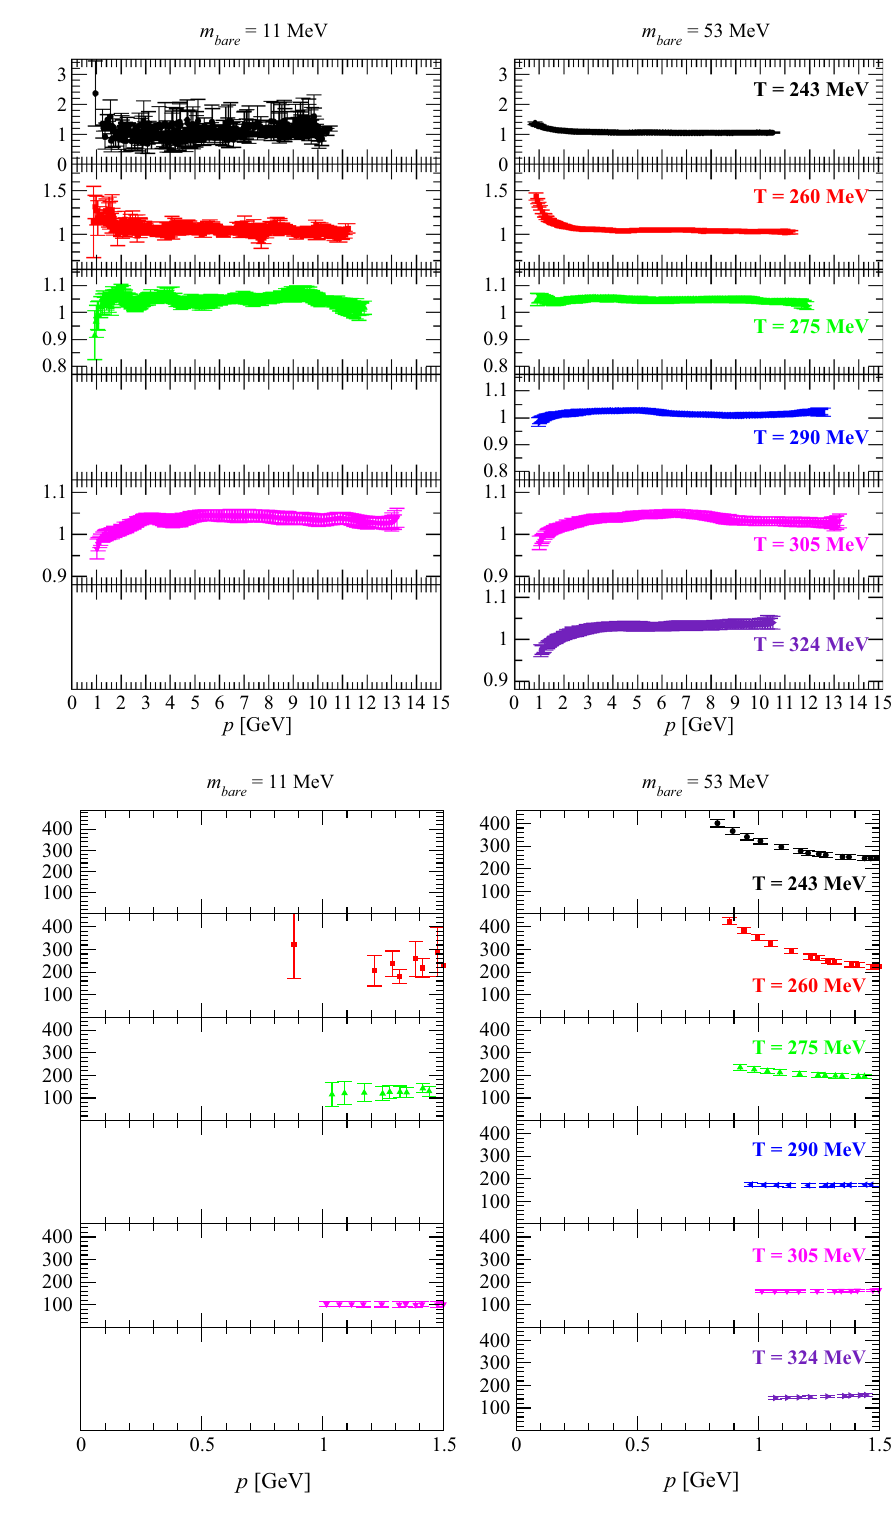
Table 1, and that is the reason why we plotted the running mass only up to p = 1 . 5 GeV. In this section, our analysis of the running quark mass refers only to its low momen-